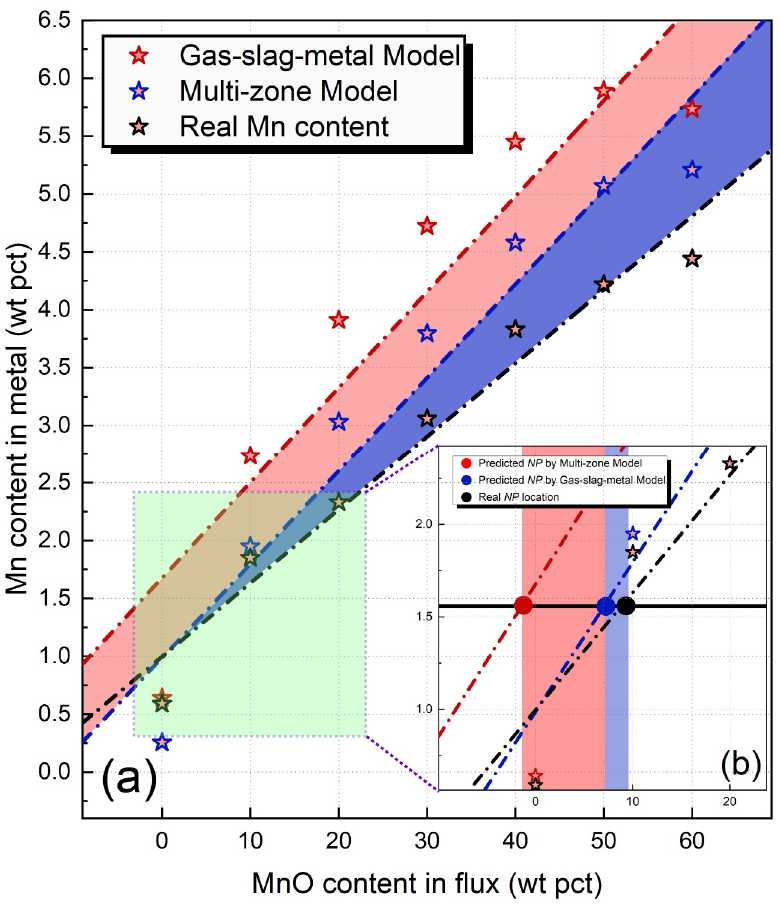
Figure 4. Predicted Mn content and NPs as a function of MnO content in flux: ( a ) predicted Mn content by equilibrium and multi ‐ zone models, and ( b ) predicted location of NP by equilibrium and multi ‐ zone models.